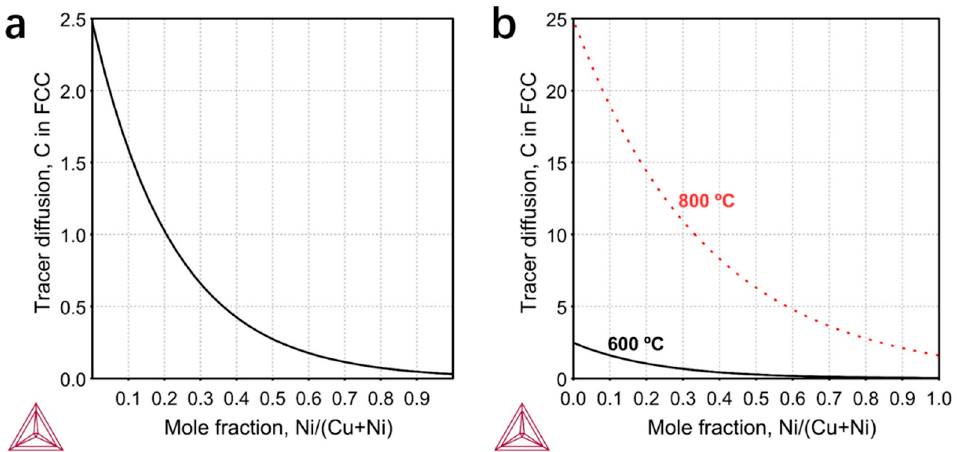
Figure 3. Theoretically determined tracer diffusivity (10 -12 m 2 /s) for ( a ) the bulk diffusion rate of carbon atoms in alloys with different Ni–Cu ratios at 600 °C. ( b ) The bulk diffusion rate of carbon atoms in alloys with different Ni–Cu ratios at 600 °C and 800 °C.